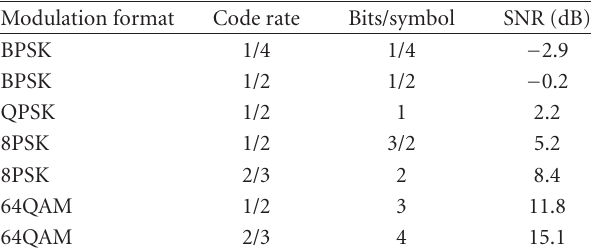
Table 1: Adaptive coding and modulation